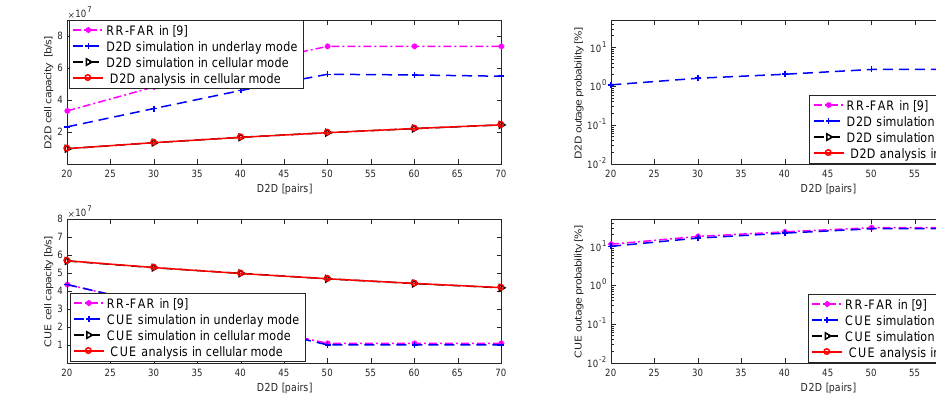
Fig. 5: D2D and CUE cell capacity as function of the number of D2D pairs in underlay mode scheme) and cellular mode ( CELLM ) for CUE (D2D) transmission power of 24 dBm (21 dBm). in the next-generation cellular networks. Based